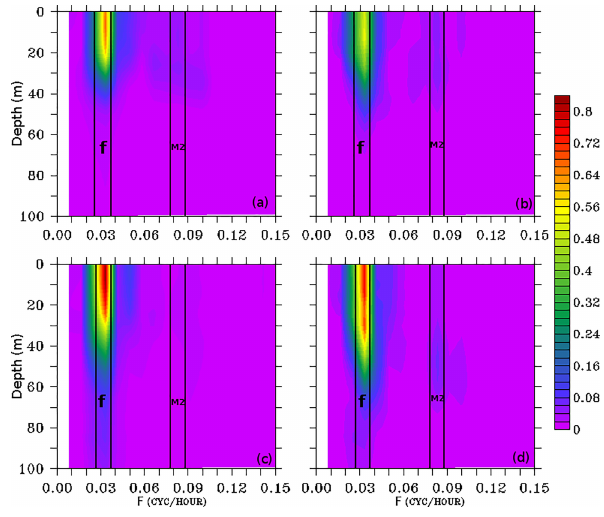
Figure 7. The power spectrum analysis (m 2 s − 1 ) performed on the simulation period at the on-track (upper panel) and off-track (lower panel) locations for (a, c) the baroclinic zonal current and (b, d) the baroclinic meridional